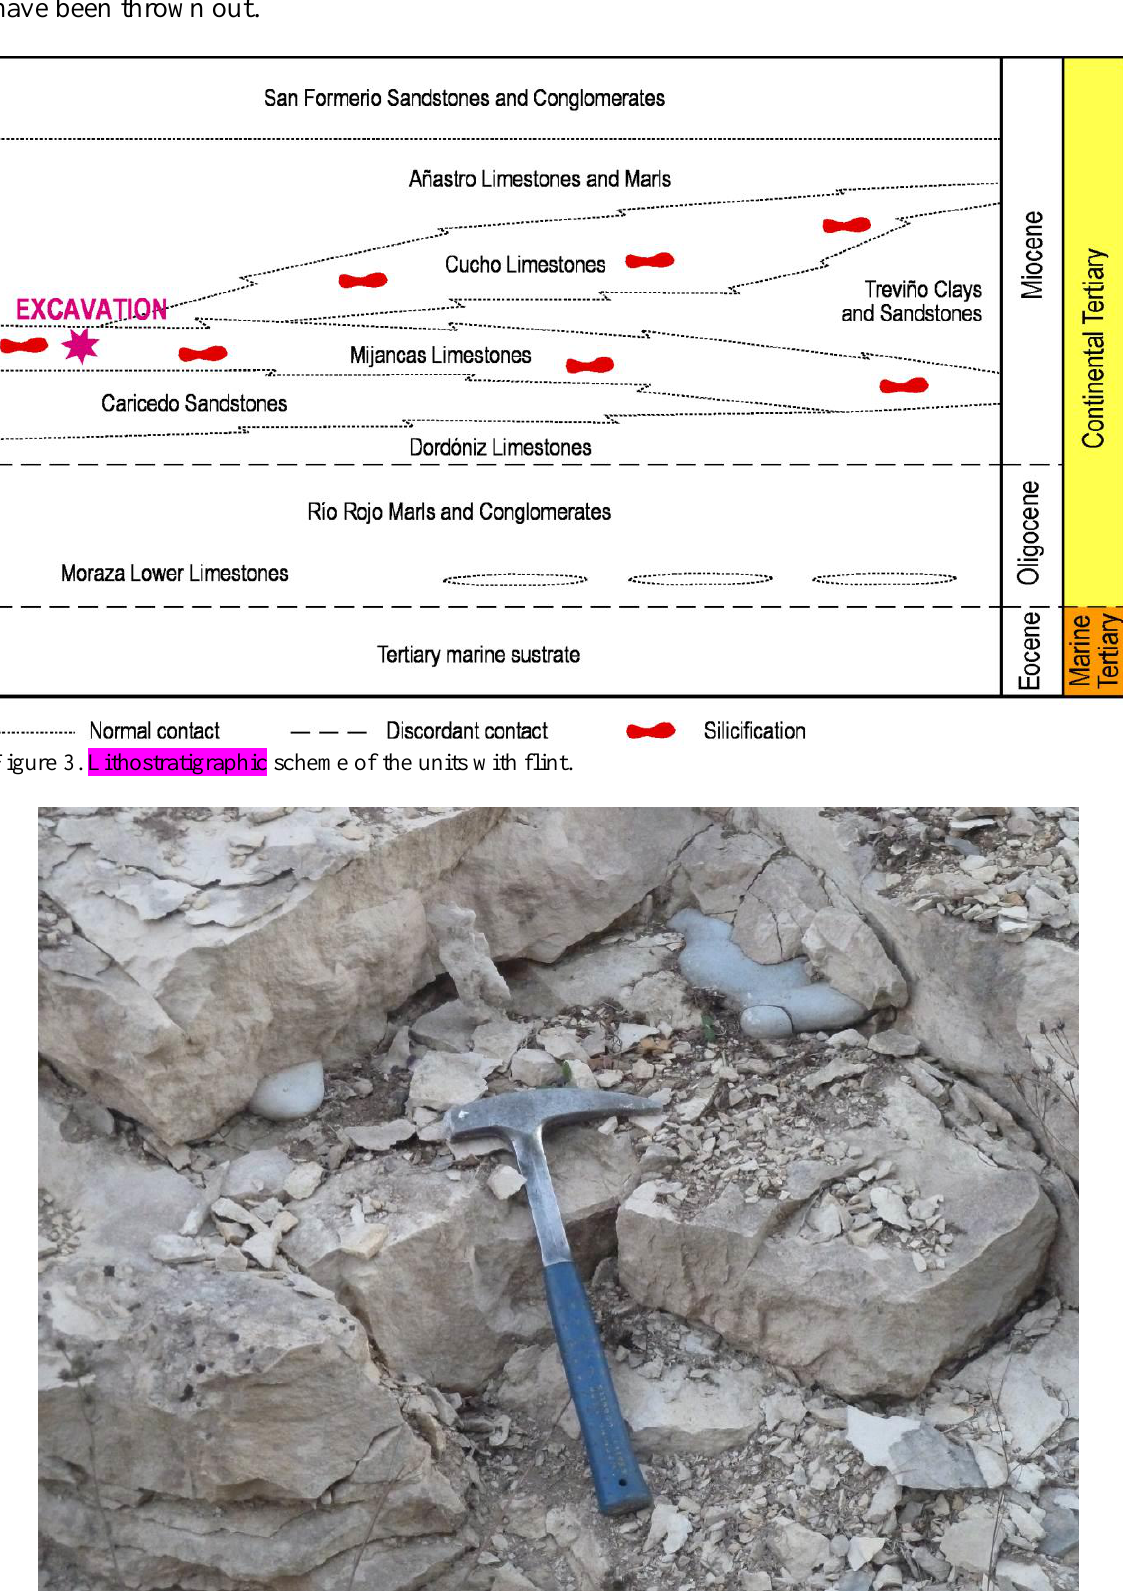
Figure 4. Outcrop of the nodular flints exploited at the mines, without cortex, included in the poorly consolidated lacustrine-palustrine